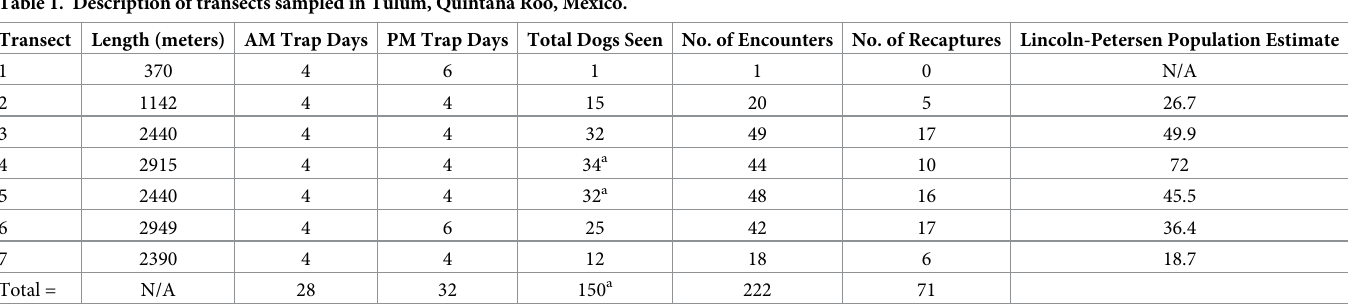
Table 1. Description of transects sampled in Tulu´m, Quintana Roo,